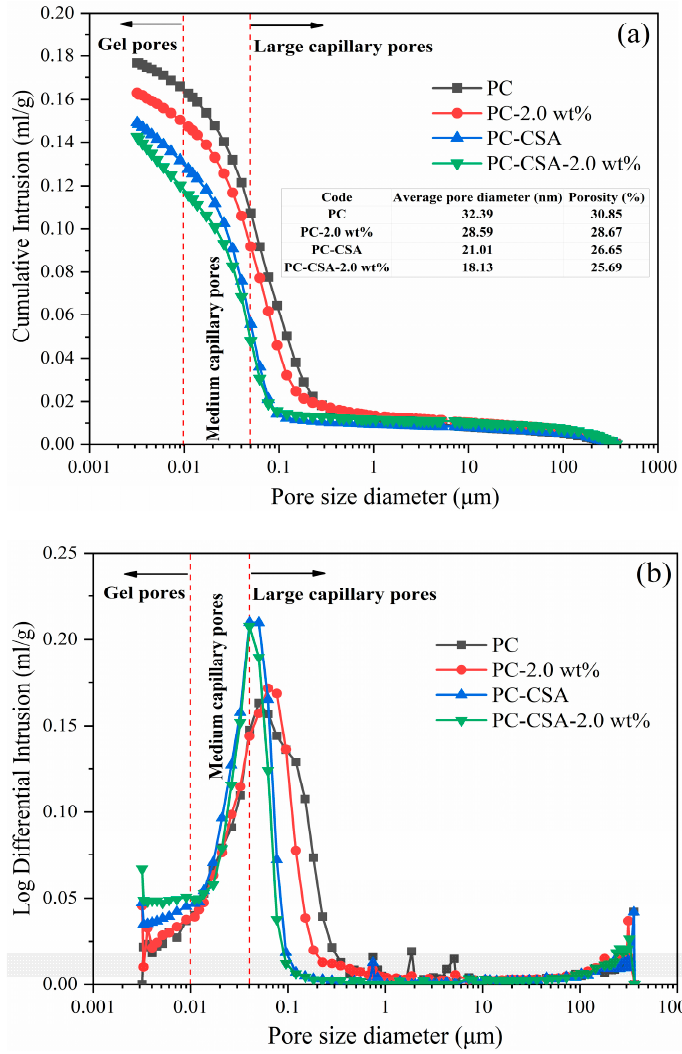
Figure 11. The pore structure of cement at 10 h curing: ( a ) cumulative intrusion; ( b ) differential intrusion.